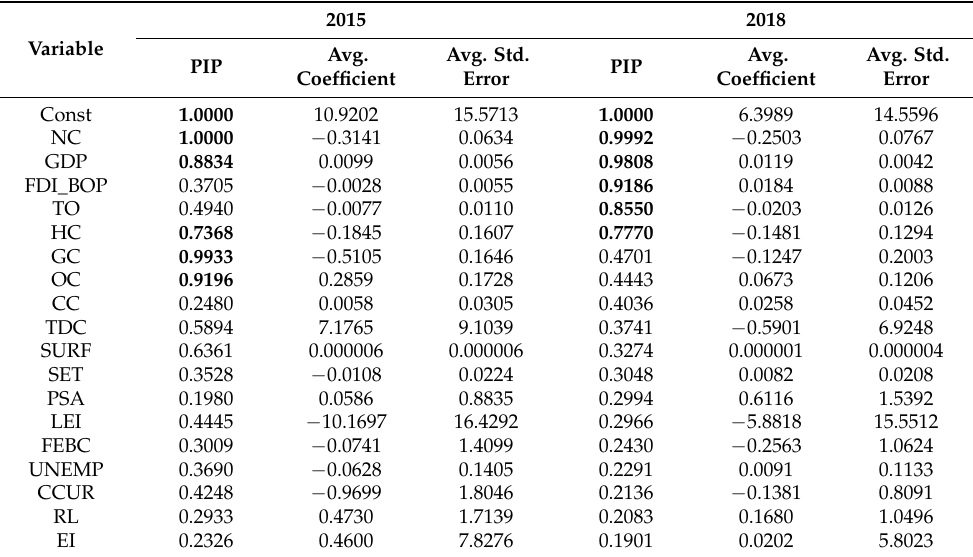
Table 3. Posterior estimates of renewable consumption determinants in 2015 and